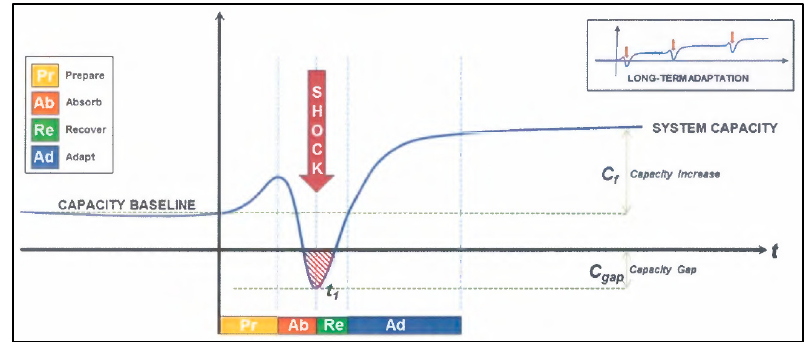
Figure 2. NATO’s strategic resilience concept [16].